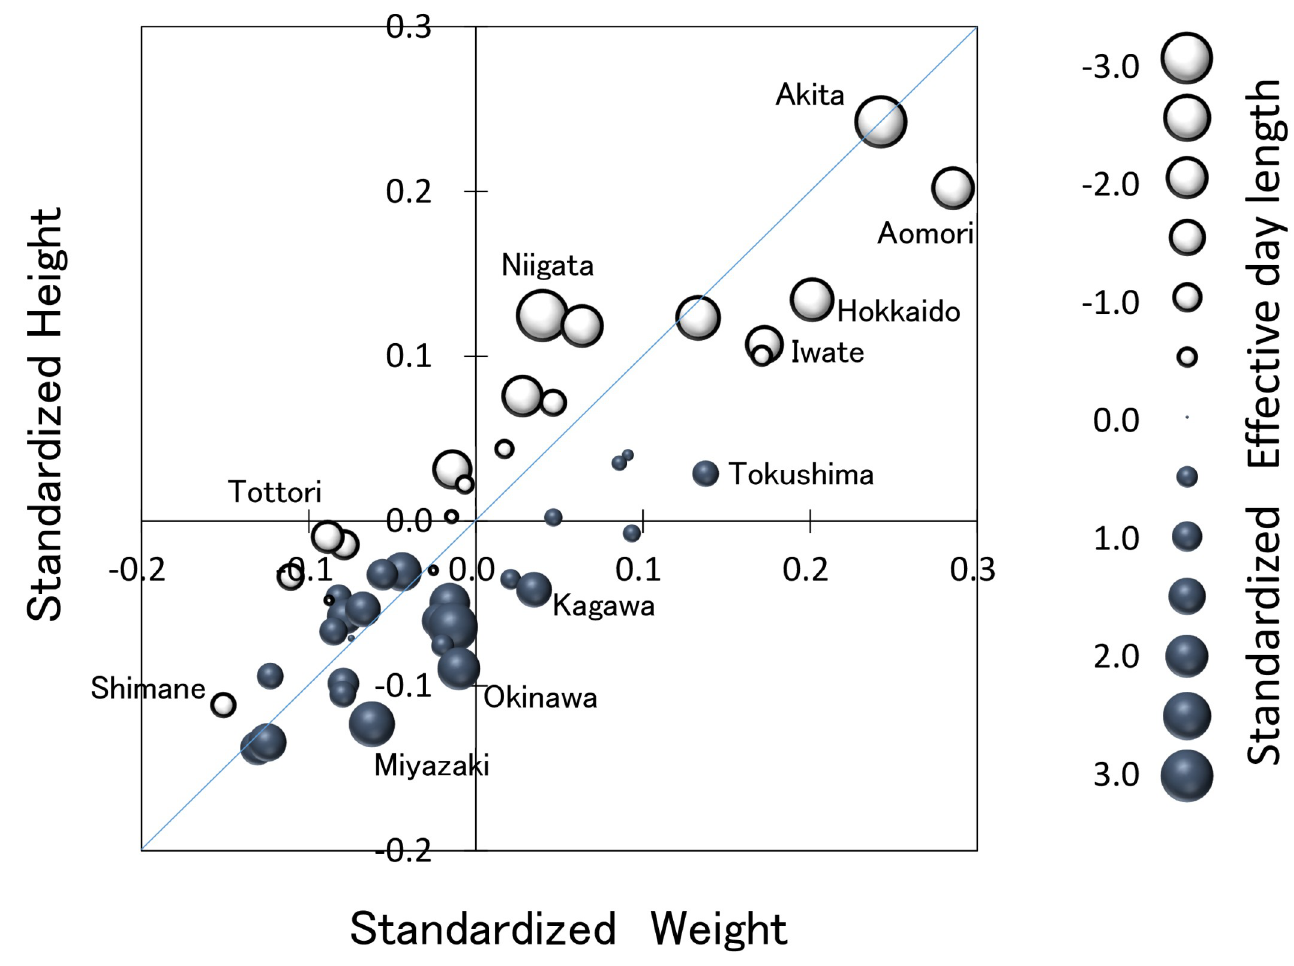
Fig 3. Relationship between standardized heights and weights. The relationship between standardized heights and weights in 12-year-old boys. The length of the standardized annual mean effective day length at 5000 lux is indicated by the size of the plot.